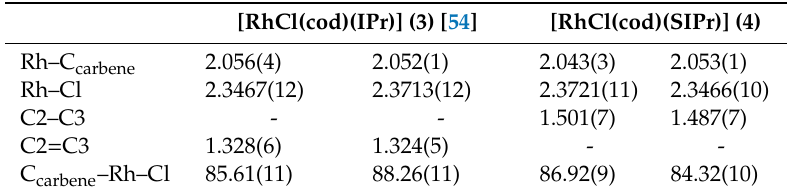
Table 1. Comparison of the most important bond lengths (Å) angles ( ◦ ) of [RhCl(cod)(IPr)] ( 3 ) [54] and [RhCl(cod)(SIPr)] ( 4 ) crystallized from CHCl 3 (this work).